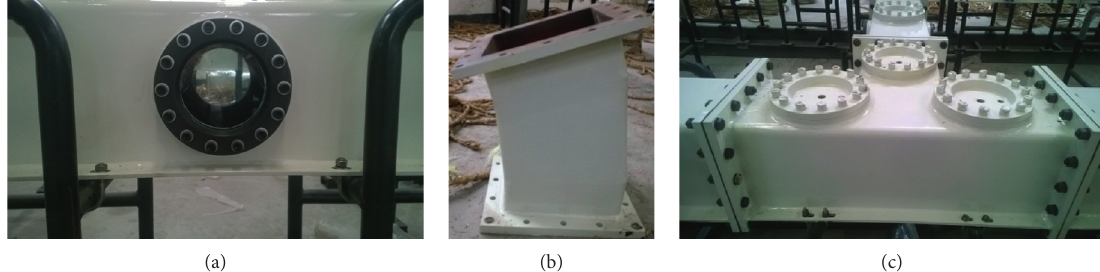
Figure 4: Simulation roadway. (a) Straight pipe. (b) Bending pipe. (c) Three-way pipe.